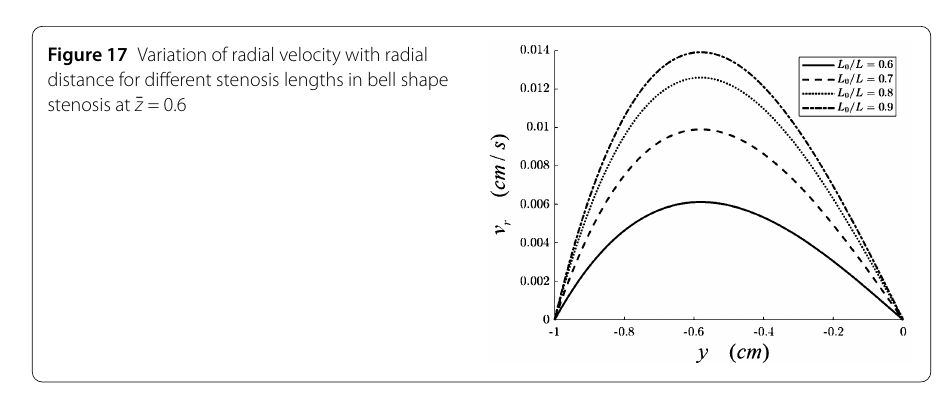
Figure 18 Variation of radial velocity with axial distance for different stenosis lengths in bell shape stenosis at y =